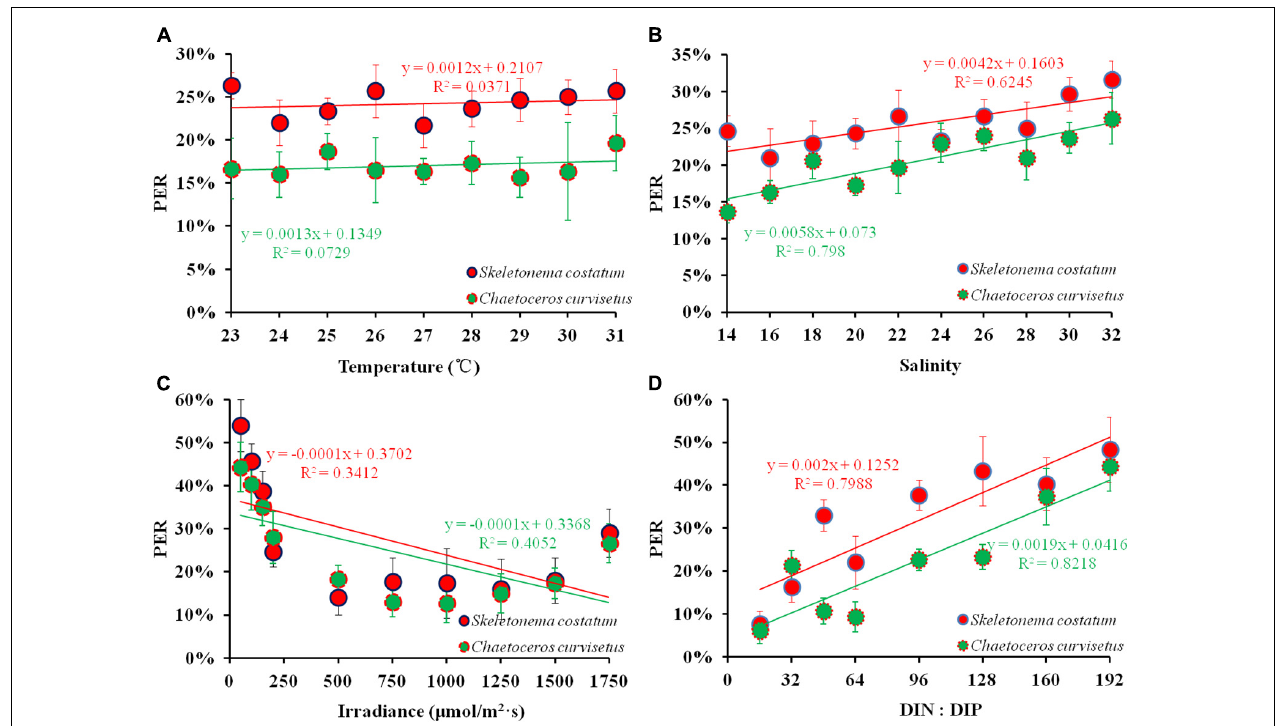
FIGURE 10 | PER under varying environmental factors [ (A) temperature; (B) salinity; (C) irradiance; (D) DIN : DIP] in the exponential growth phase of cultured